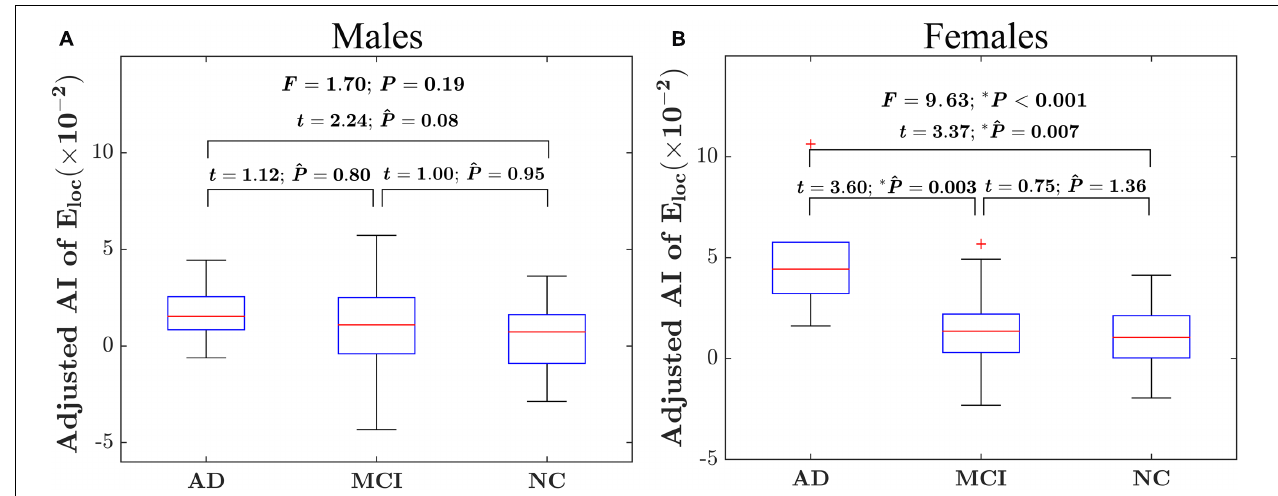
FIGURE 2 | Between-group differences on the AI of the local network efficiency of the hemispheric networks in males and females. (A) The box plots of the group differences on the AI of local network efficiency in males. (B) The box plots of the group differences on the AI of local network efficiency in females. Before conducting the group comparisons, the data were adjusted for whole-brain ICV, hemispheric ICV difference, age, gender, and TR and TE from diffusion-weighted imaging. ˆP represents the Bonferroni-corrected P- value of post hoc analysis.